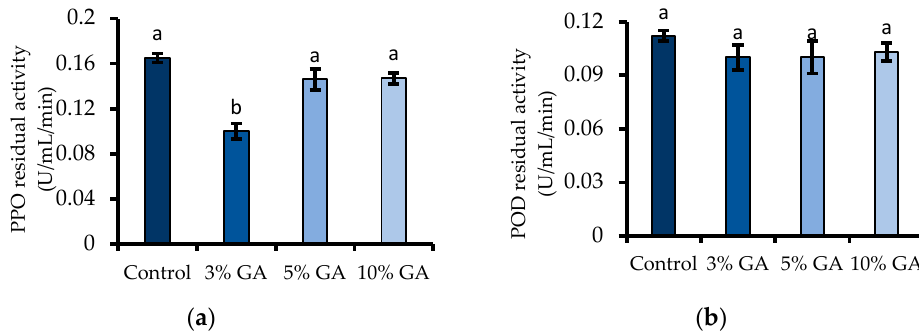
Figure 5. ( a ) Polyphenol oxidase (PPO), ( b ) peroxidase (POD) of the control, GA-pretreated, and oven-dried (60 °C for 18–24 h) raspberries. Different letters on each bar indicate significant differences in the means ( p < 0.05), according to Duncan’s multiple range test. Vertical bars indicate the standard deviation of the mean. Control samples were dipped in distilled water for 2 min. GA = gum arabic.